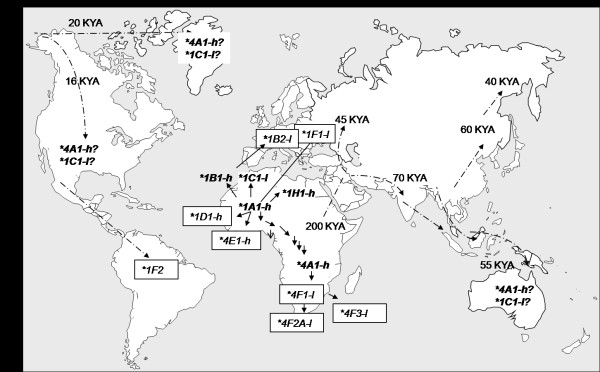
Distribution and origins of the MBL2 alleles in the world. Arrows denote the mutational steps between haplotypes (six between *1 and *4) and when dotted, the ancient migratory routes with their approximate ages [51]. The haplotypes which could have been lost by natural selection and/or genetic drift were denoted by '?'. In bold: haplotypes generated before human out-of-Africa migration. Squared: more recent haplotypes, with geographically restricted distribution. KYA thousand years ago.